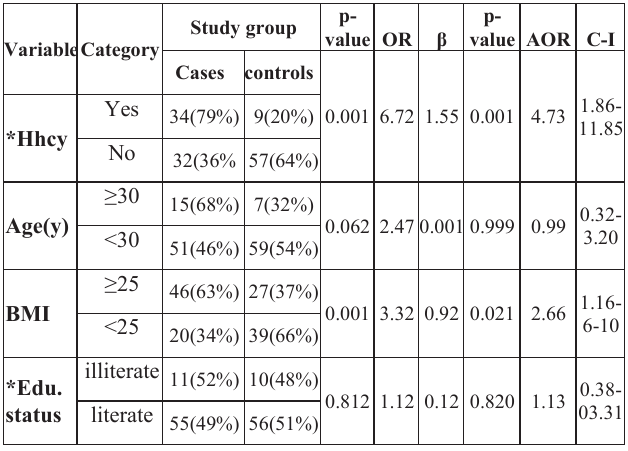
Table- 4: Logistic Regression model to determine Association between hyperhomocysteinemia and Preeclampsia (n